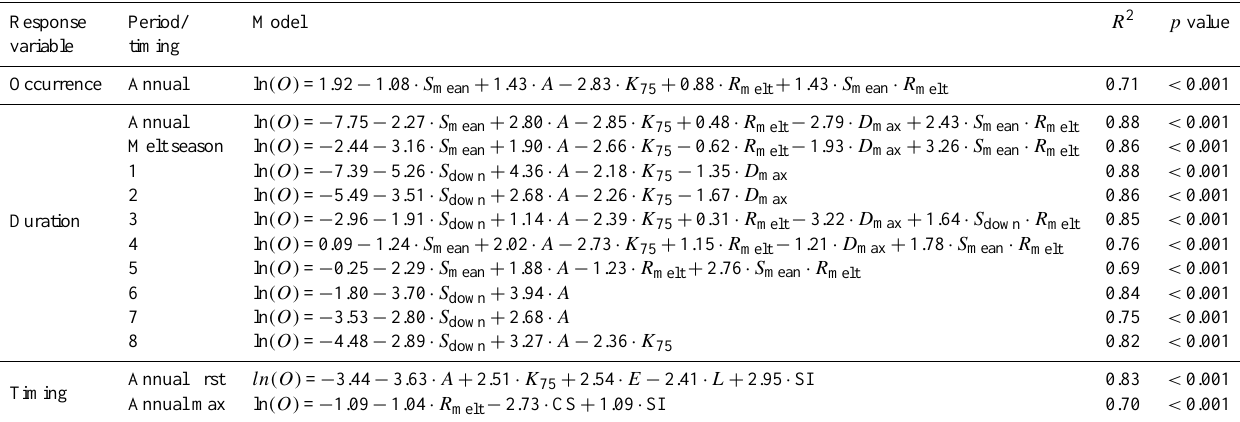
Table 4. Ordinal logistic regression models for the occurrence of response over the annual period; the duration of response over the annual period, melt period, and periods 1 through 8; and the timing of first and maximum responses over the annual period. For modeling, the measured response values were replaced with the class values of 0, 1, or 2, as provided in Table 3. The predictor variable symbols are defined in Table